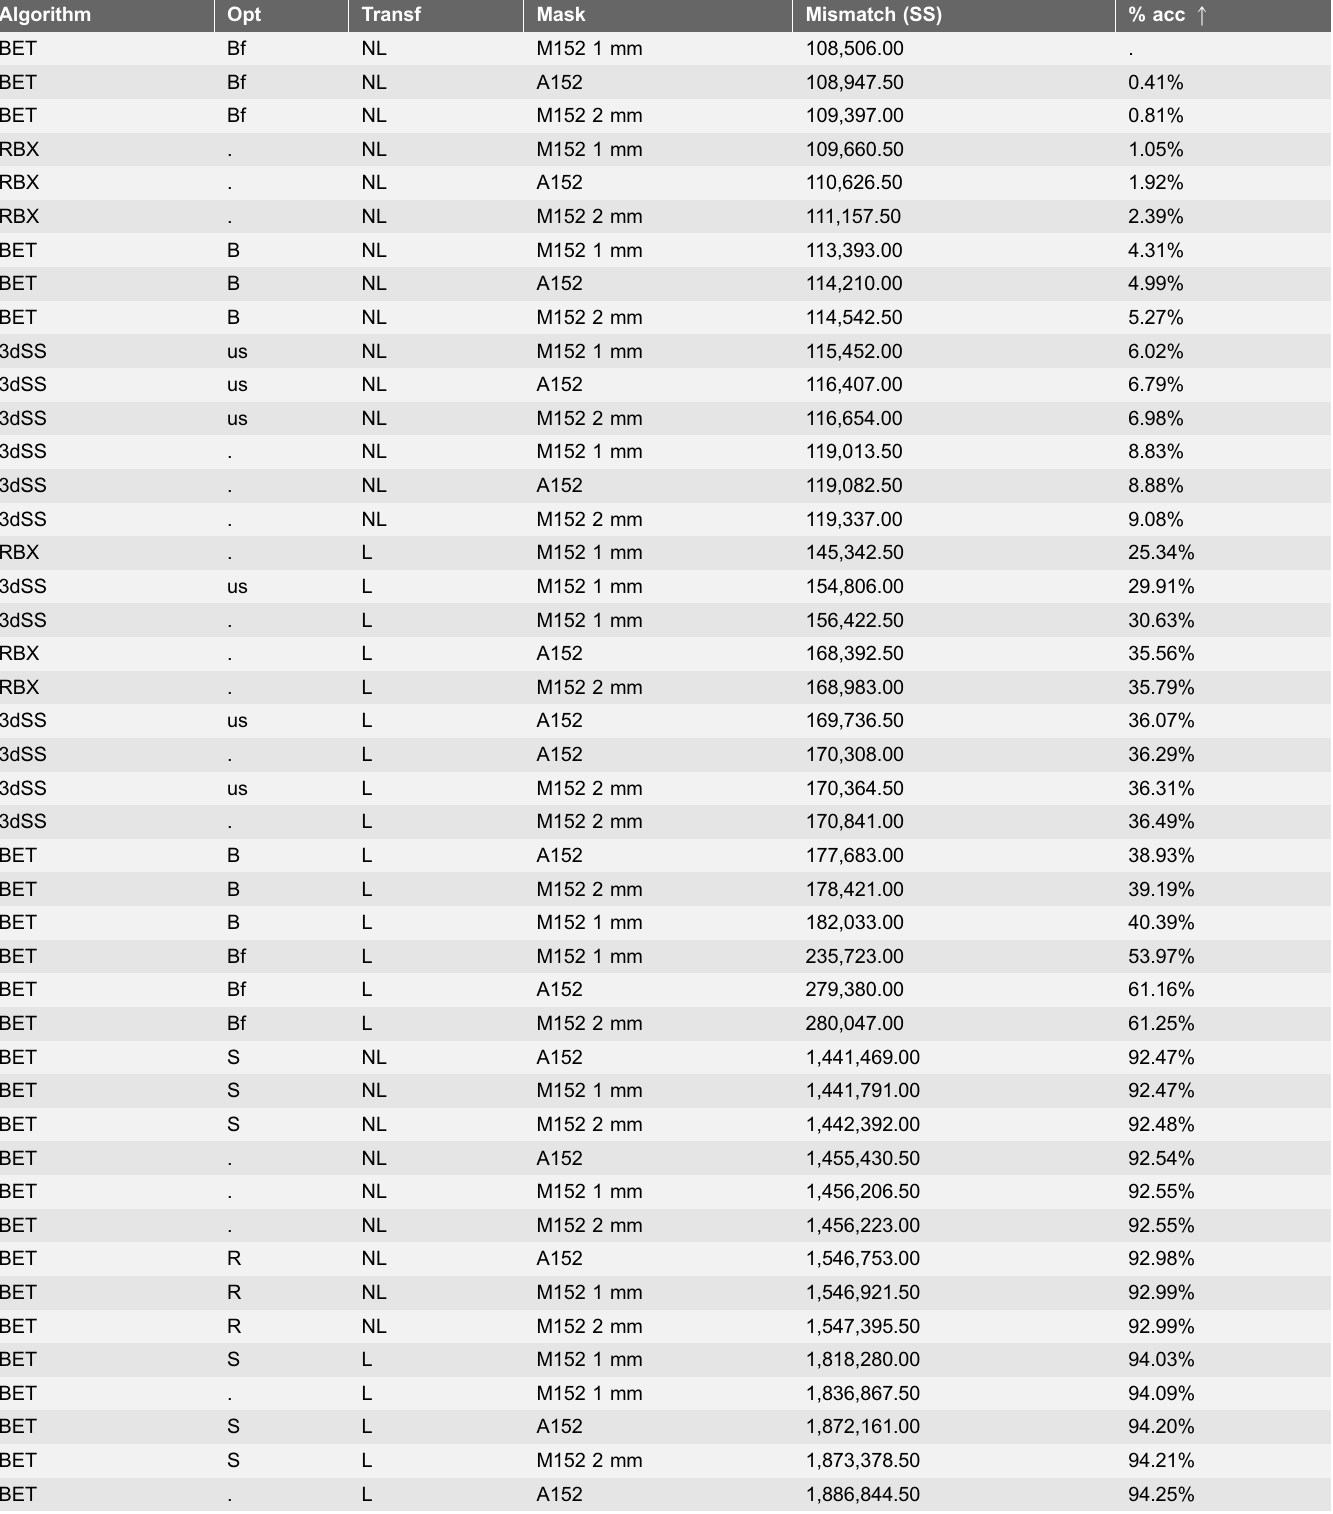
Table 1. Optimization results ordered by median